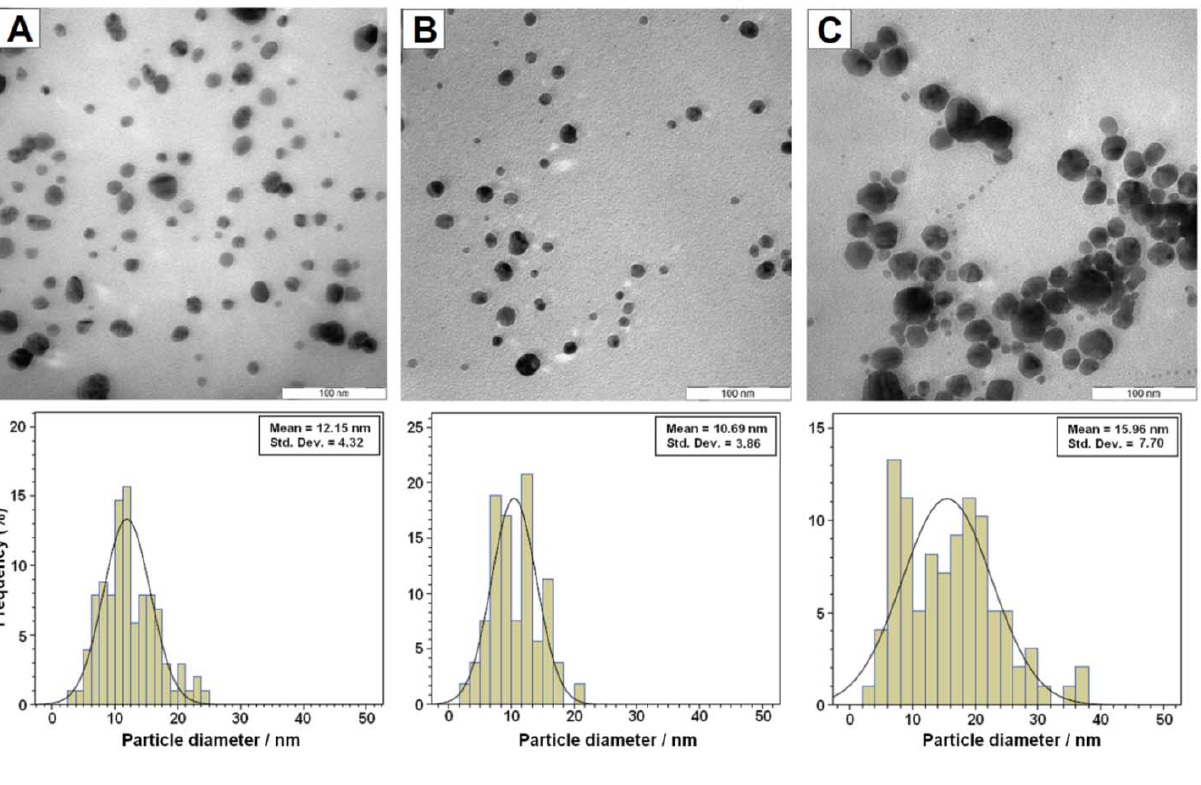
Figure 4. TEM images of Ag-NPs and their particle size distribution at different volumes of NaOH; 1.5 ( A ), 5 ( B ), and 10 mL ( C